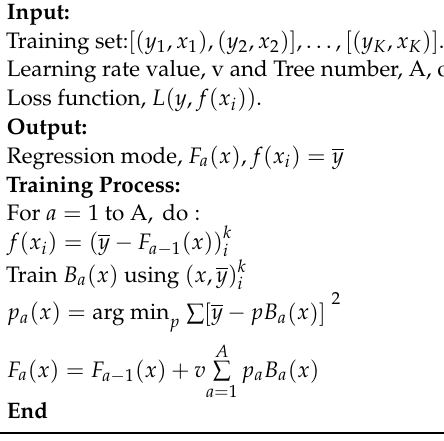
Algorithm 1: Also, The RF Regression with least-squares boost (LS-Boost) is given in Algorithm 1.